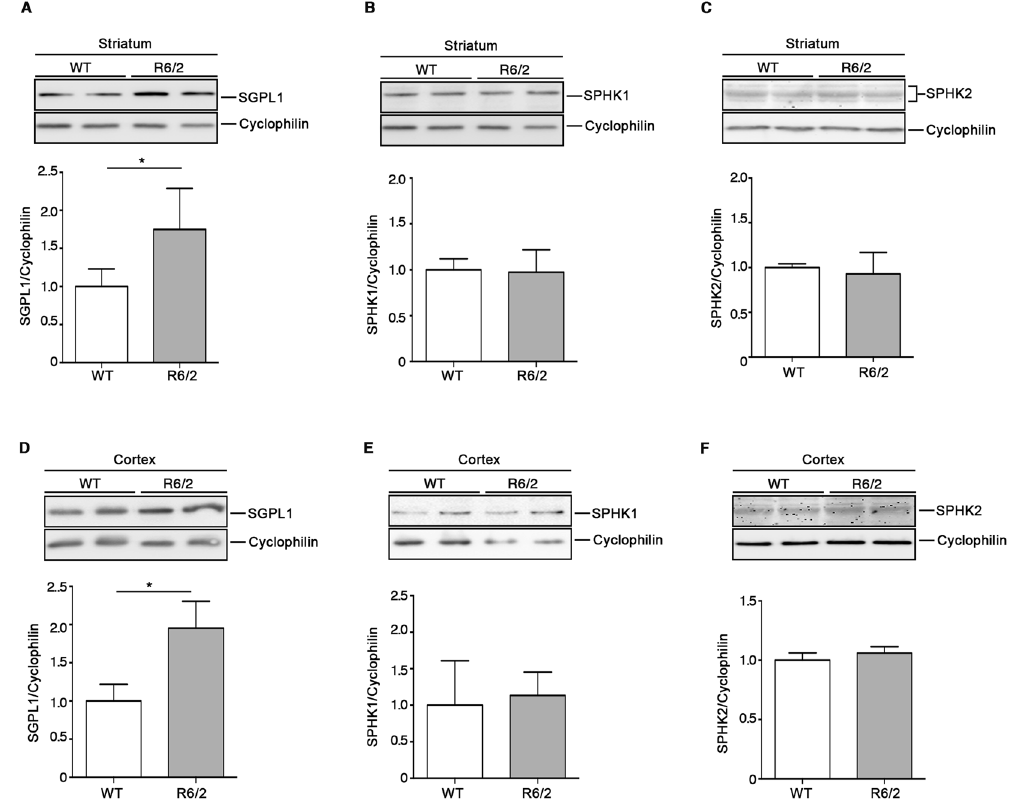
Figure 7. Levels of both SGPL1 are defective in brain tissues from R6/2 mice at early stages of the disease. Representative cropped immunoblottings and densitometric analysis of SGPL1 and SPHK1/2 isoform expression in striatal ( A – C ) and cortical ( D , E ) tissues from early manifest (6 week old) R6/2 mice and WT littermates. Values are represented as mean ± SD. N = 5 for each group of mice. ** p < 0.001 (Unpaired